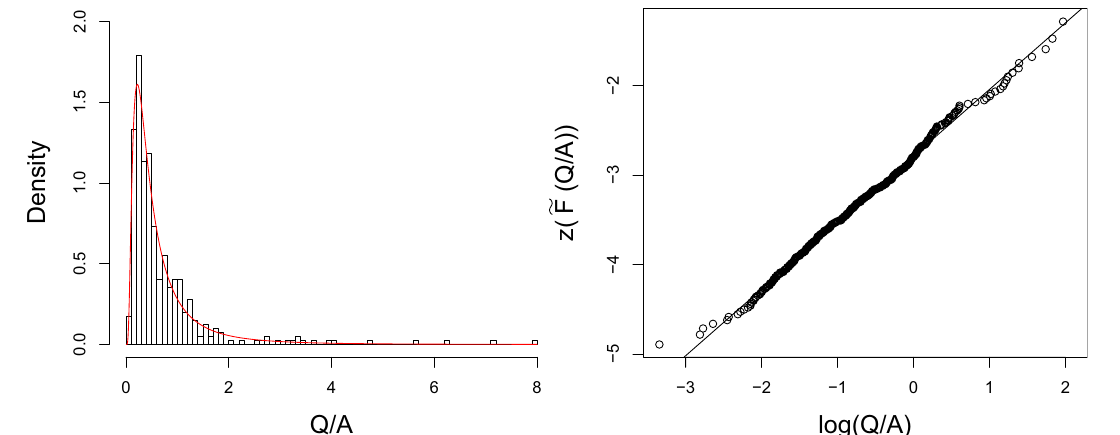
Figure 2. Empirical and fitted density curve (left panel) and probability plot (right panel), under the homogeneity hypothesis.